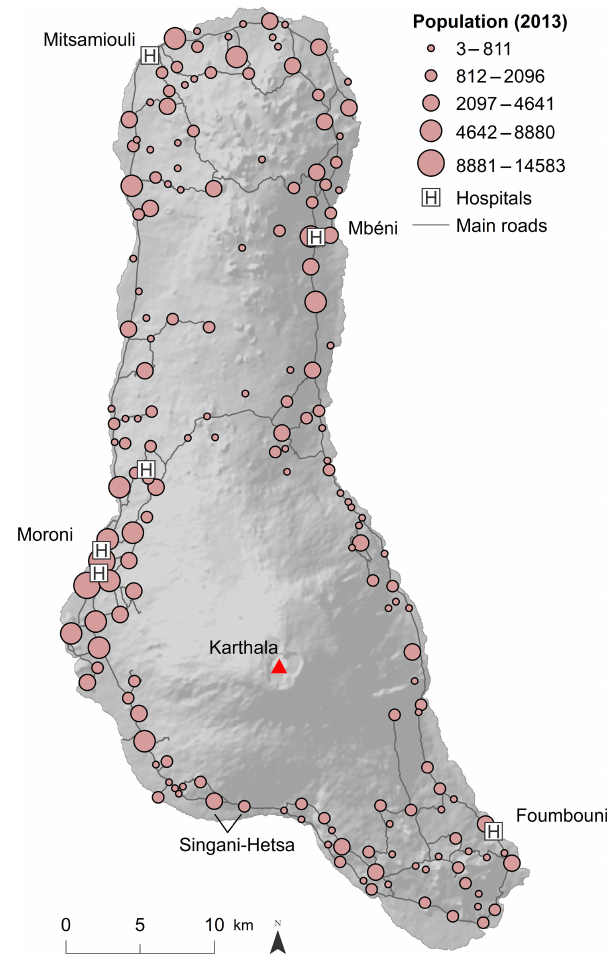
Figure 2. Population repartition estimated for 2013 (Mossoux et al., 2018) and location of the hospitals (Centre d’Analyse et de Traite- ment de l’Information, 2016) considered in the road accessibility risk and users’ path vulnerability